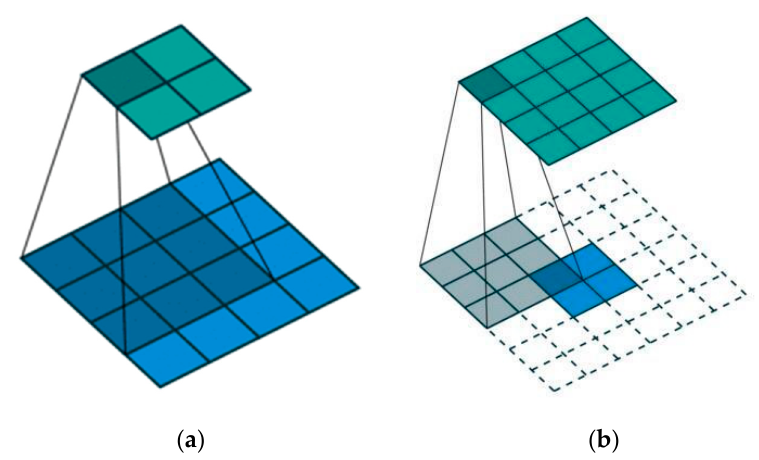
Figure 2. Standard convolution ( a ) and TC ( b ) (blue is input, shadow is filter size, green is output). TC is not exactly the reverse operation of standard convolution, but it reconstructs the high-dimensional state by gradually up-sampling low-dimensional representations [57].